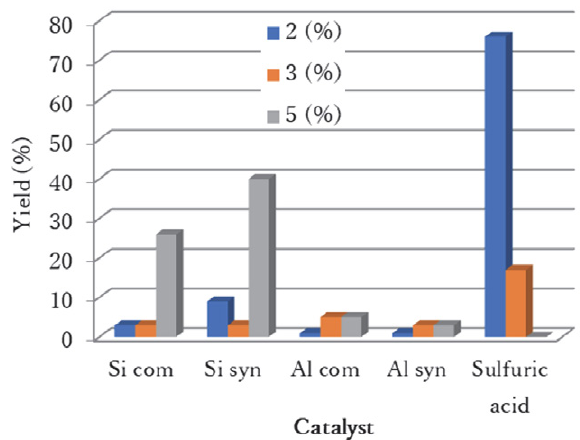
Figure 1. Evaluation of the yield of products 2 , 3 and 5 in the pres- ence of H 2 SO 4 (4% wt.) and of catalysts based on silica gel and alu- mina (1.3% wt.).